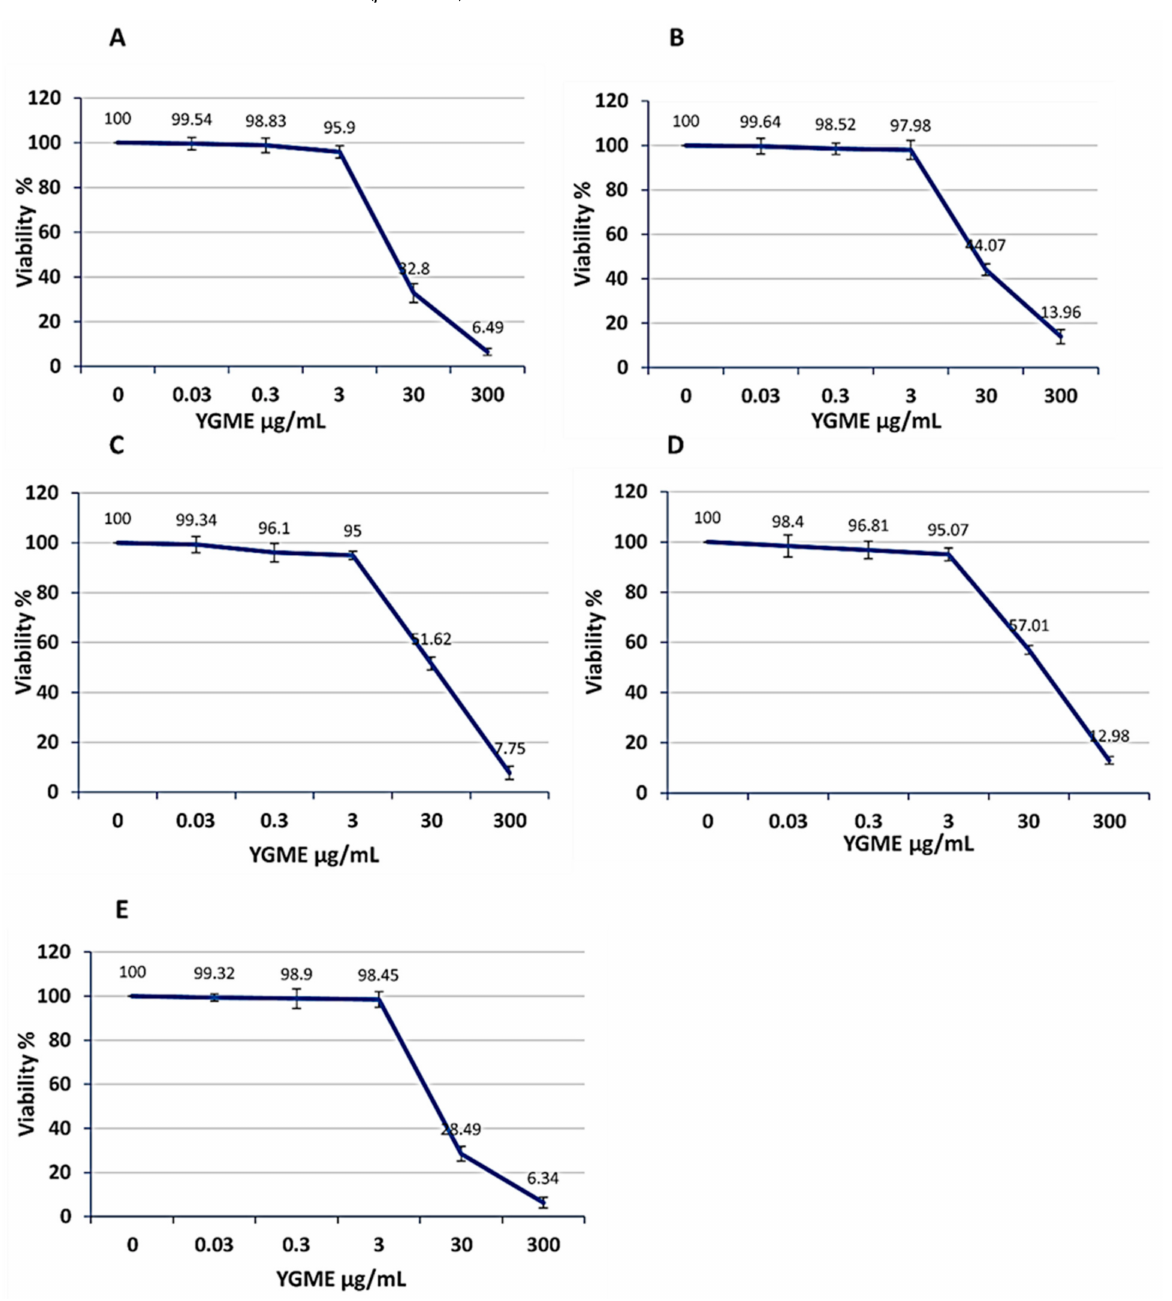
Figure 3. SRB cell viability assay for determination of the cytotoxicity of YGME, at different concen- trations, on ( A ) A375; ( B ) Hep-2; ( C ) HSF; ( D ) A431 and ( E ) MG-63 cell lines. Values are presented as mean ± SD of 3 independent